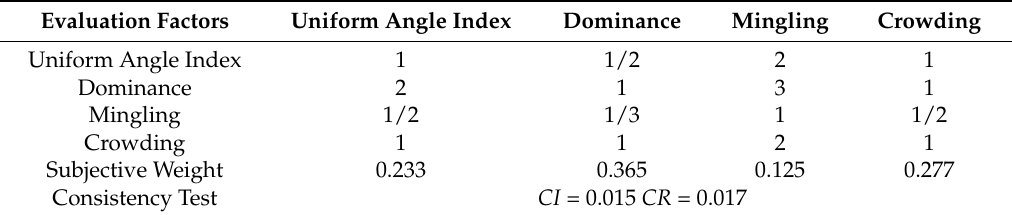
Table 7. Result and consistency test of the data layers using AHP.